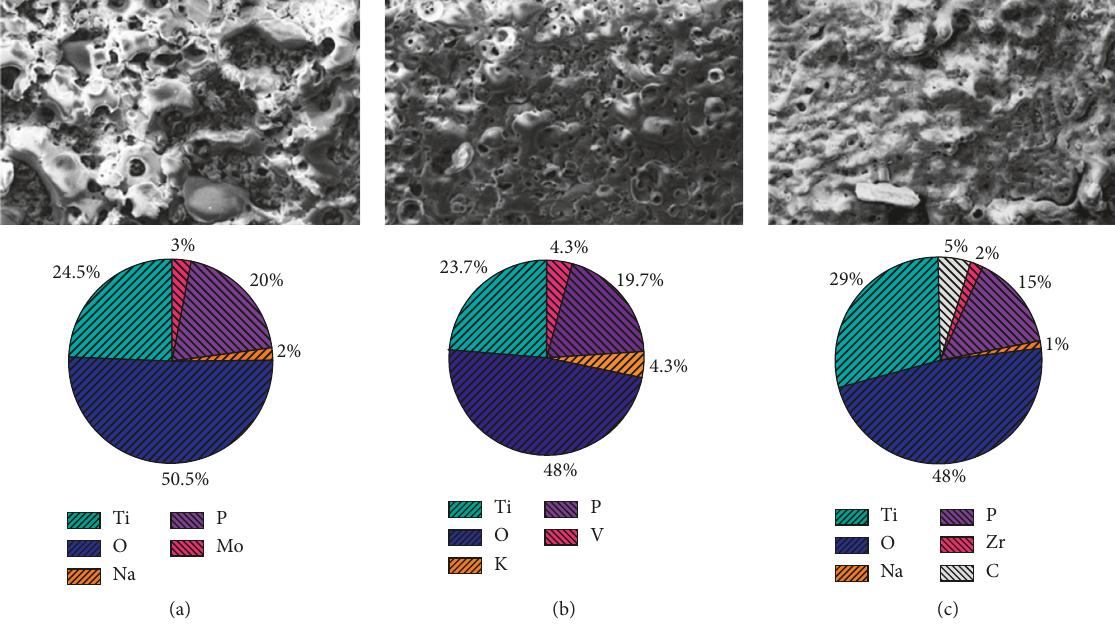
500) and composition (% by weight) of mixed-PEO coatings: (a) TiO x ×